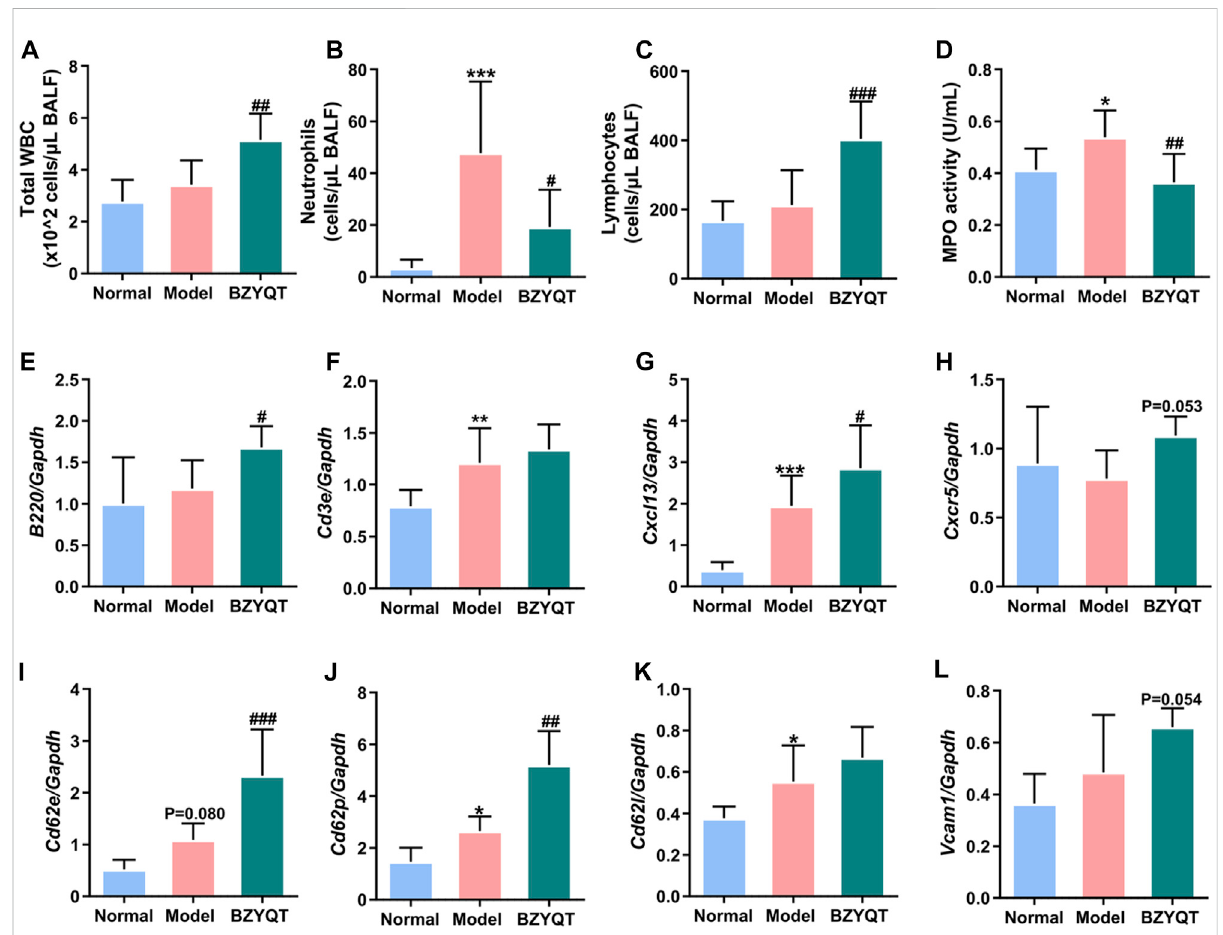
FIGURE 8 Immunomodulatory effect of BZYQT on poly (I:C)-induced pulmonary in fl ammation through prophylactic administration. The number of (A) total WBCs, (B) neutrophils, and (C) lymphocytes, (D) MPO activity in the BALF; the mRNA expression of (E) Ptprc ( B220 ), (F) Cd3e , (G) Cxcl13 , (H) Cxcr5 , (I) Cd62e , (J) Cd62p , (K) Cd62l , (L) Vcam1 in the lung tissue ( n = 8 or 9). Data were shown as mean ± SD, and analyzed by one-way ANOVA; differences identi fi ed using Dunnett ’ s multiple comparisons test: * p < 0.05, ** p < 0.01, *** p < 0.001 compared with normal group; # p < 0.05, ## p < 0.01, ### p < 0.001 compared with model